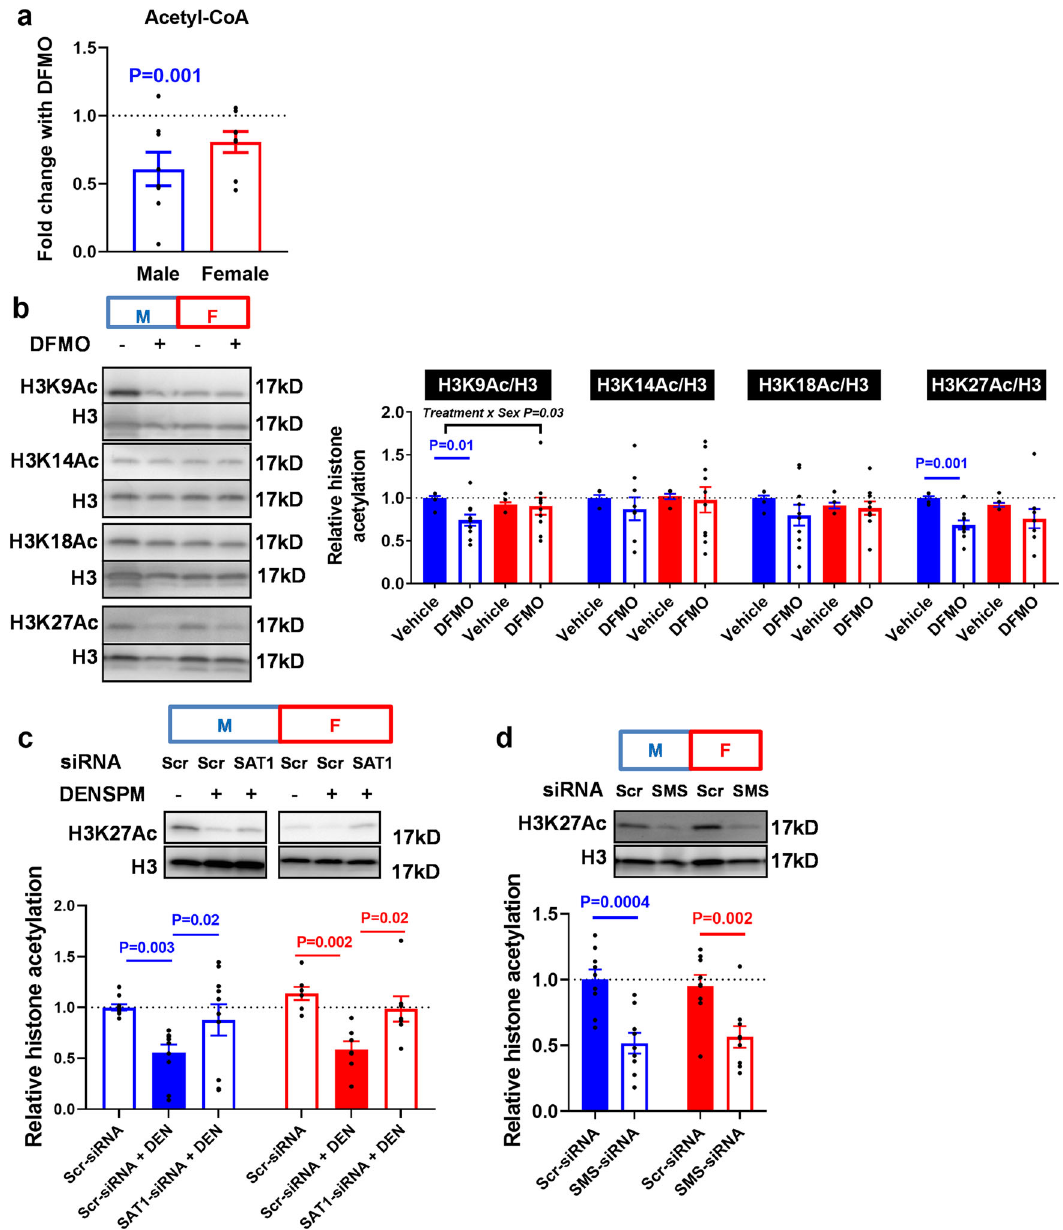
Fig. 5 Polyamine depletion reduces acetyl-coA levels and decreases histone acetylation. In male PHTs, DFMO decreases a acetyl-coA levels as measured by LC-MS and b histone acetylation as determined by immunoblotting. c H3K27Ac abundance is decreased by DENSPM (DEN) and reversed by SAT1 silencing. d H3K27Ac abundance is decreased following SMS-silencing. Bar graphs show mean ± SEM, N = 8 – 10 male PHTs and N = 8 – 10 female